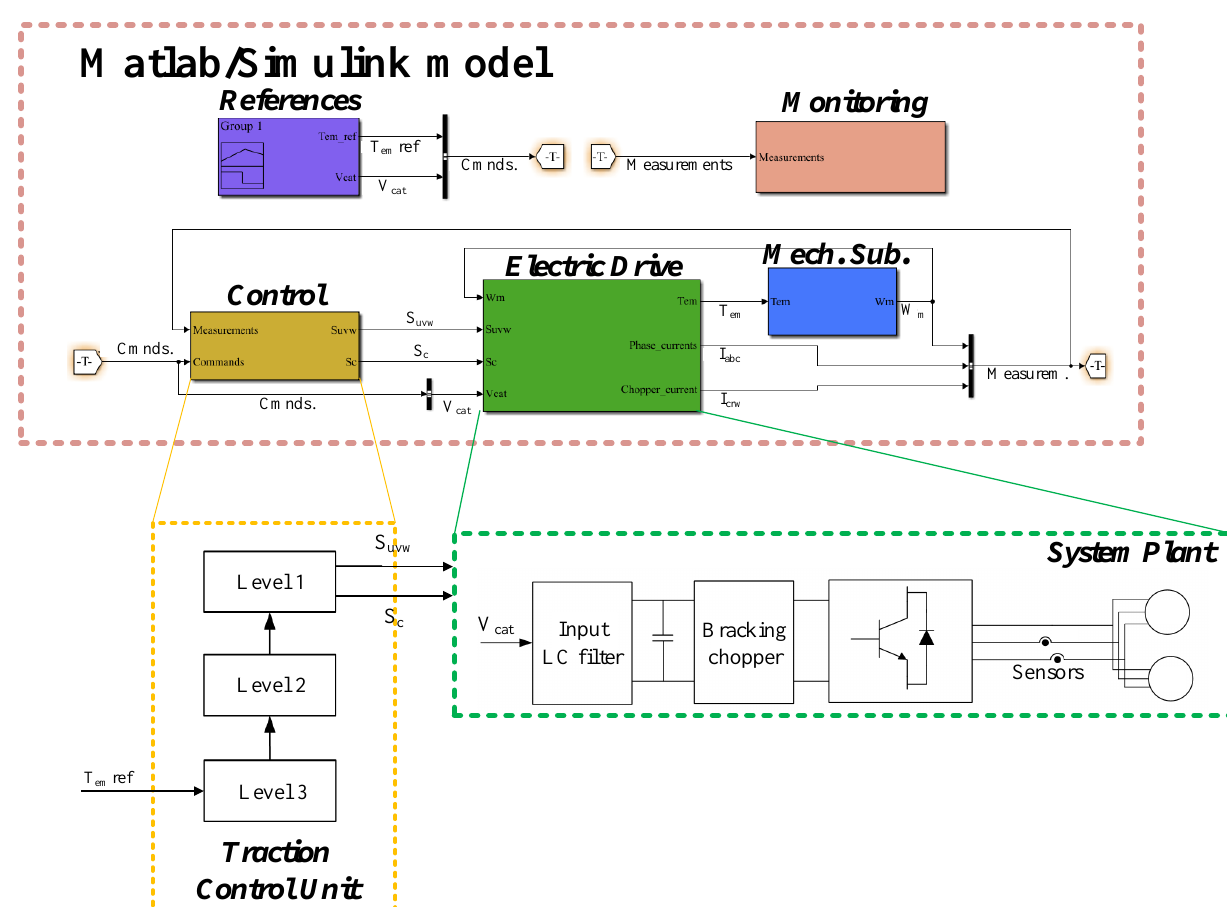
Figure 2. Schematic of the Matlab/Simulink based SiL simulation platform of a tram application for synthetic data